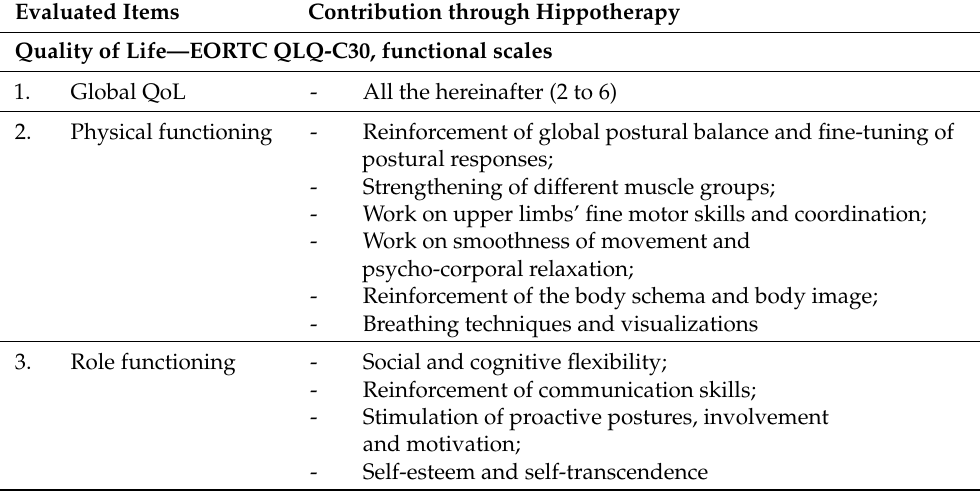
Table 4. Functional items measured and their link to the exercises addressed by the hippotherapy protocol based on work on the horse (movement of the horse at a walk) and by the horse, targeting various interrelated health functioning